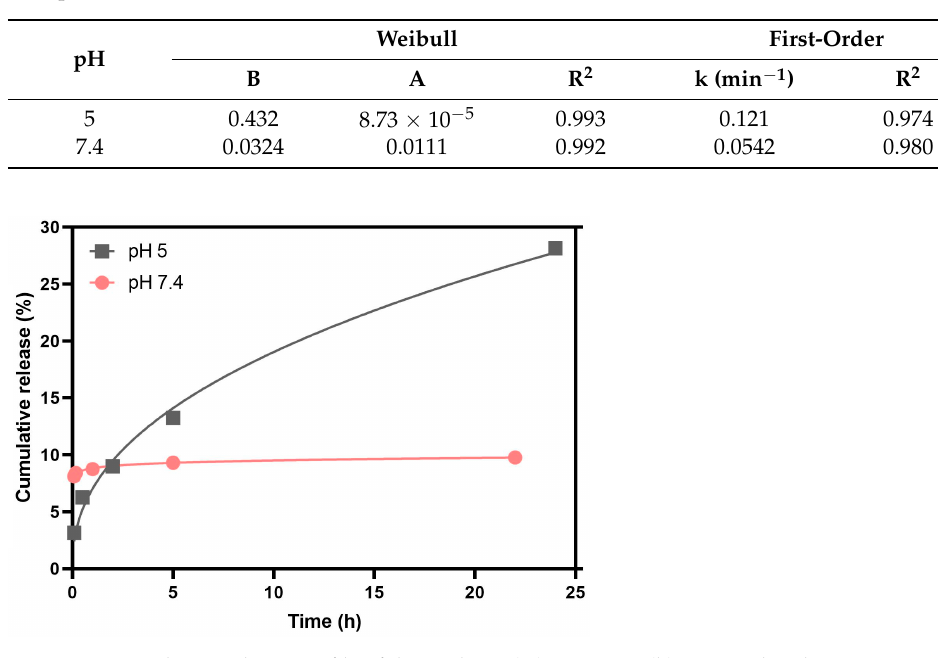
Figure 8. Cumulative release profile of doxorubicin (%) over time (h) encapsulated in SMLs at pH = 5 (gray line) and pH = 7.4 (red line), fitted to the Weibull model.